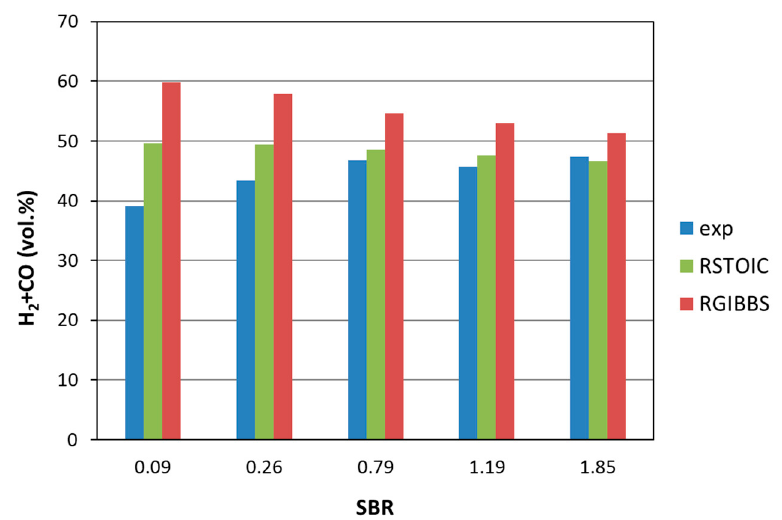
Figure 6. Comparison between experimental and simulation results for the produced gas composition at different steam to biomass mass ratios, for the gasification of PKS at 900 °C with SR =